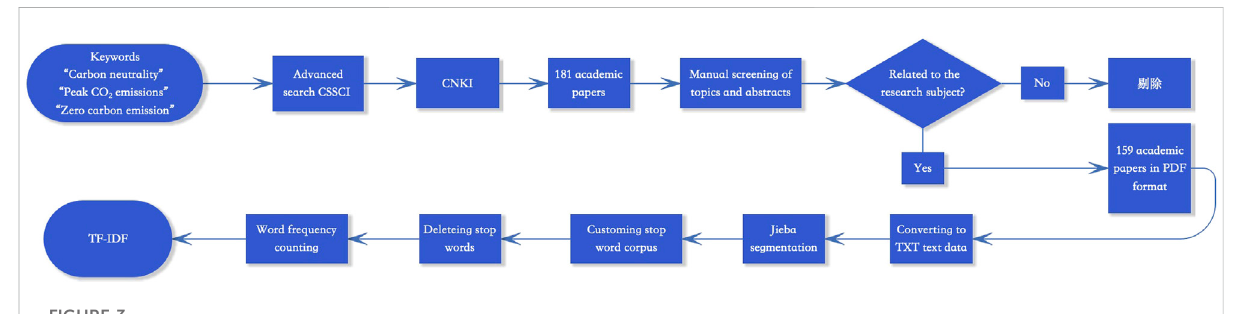
FIGURE 3 Text data collection and cleaning